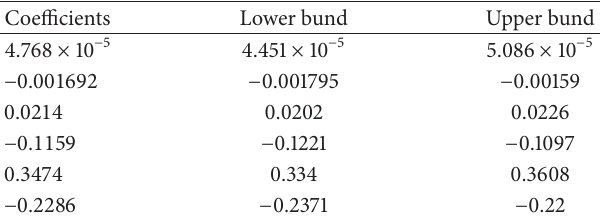
Table 5: 95% confidence interval for estimated coefficient of 𝑓(𝑡 𝑚 ) .